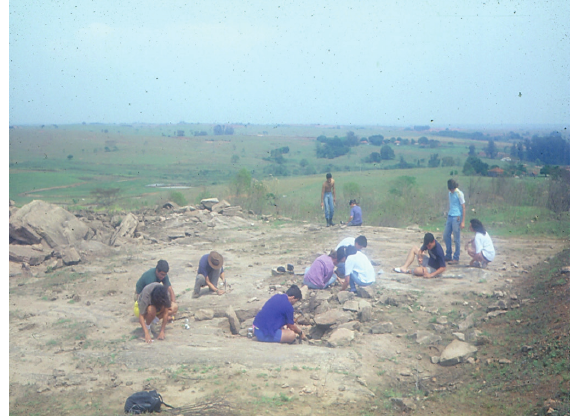
Figure 4 - the abandoned quarry Southwestern Santo Anastácio City, São Paulo State; an image from 1990.